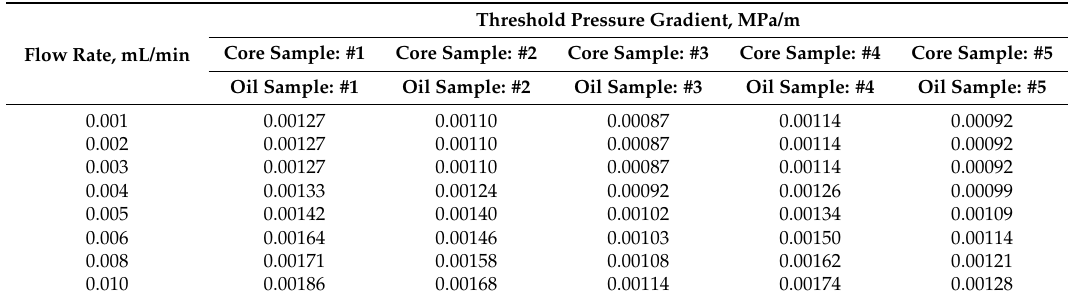
Table 4. The TPG measured at the different flow rate.